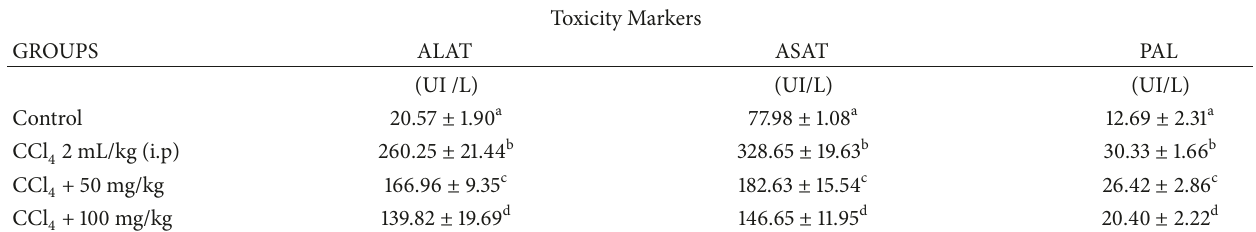
Table 4: Effect of the water-ethanol extract of Tetrapleura tetraptera on some toxicity markers in vivo.